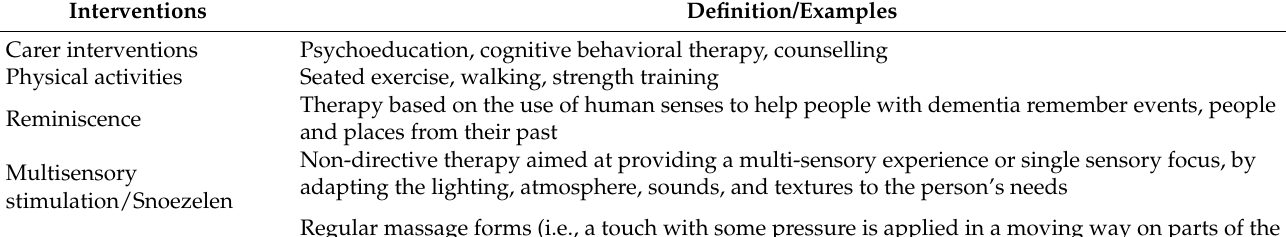
Table 1. List of psychosocial